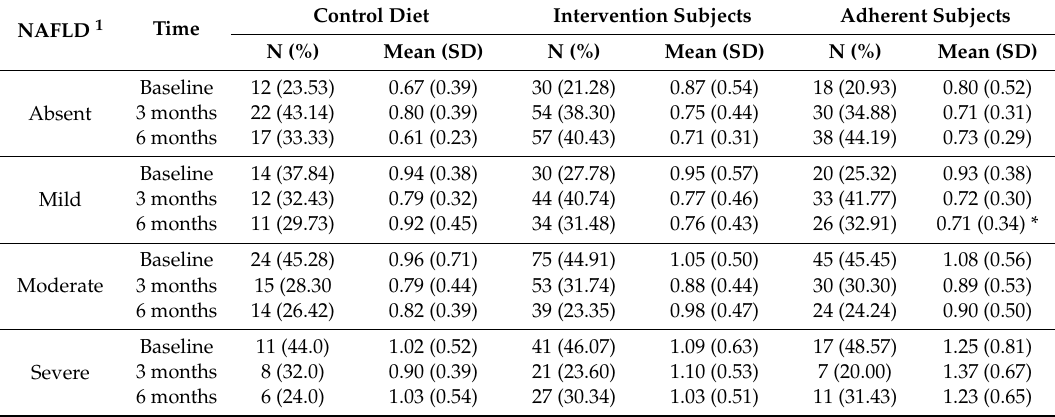
Table 2. Remnant cholesterol levels by NAFLD severity and time in control subjects, whole sample, and adherent subjects.